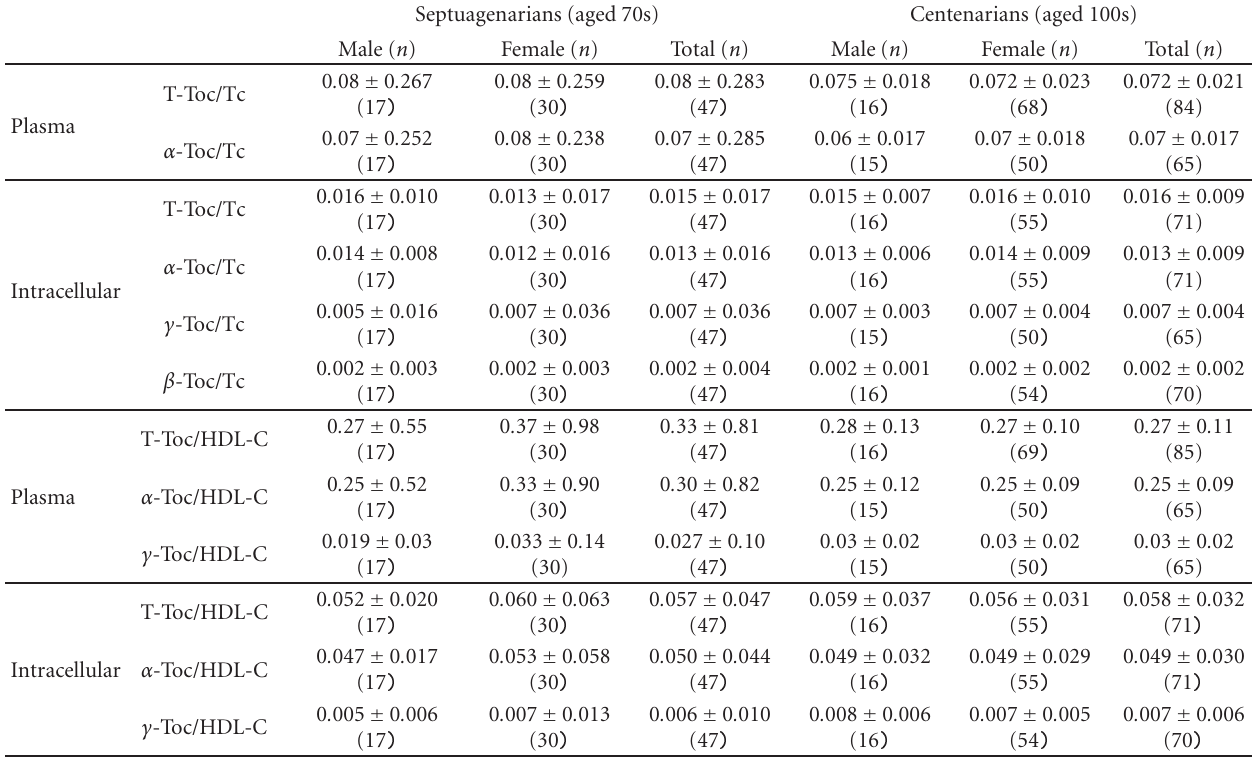
Table 4: Plasma and intracellular tocopherols adjusted by lipid subfraction.